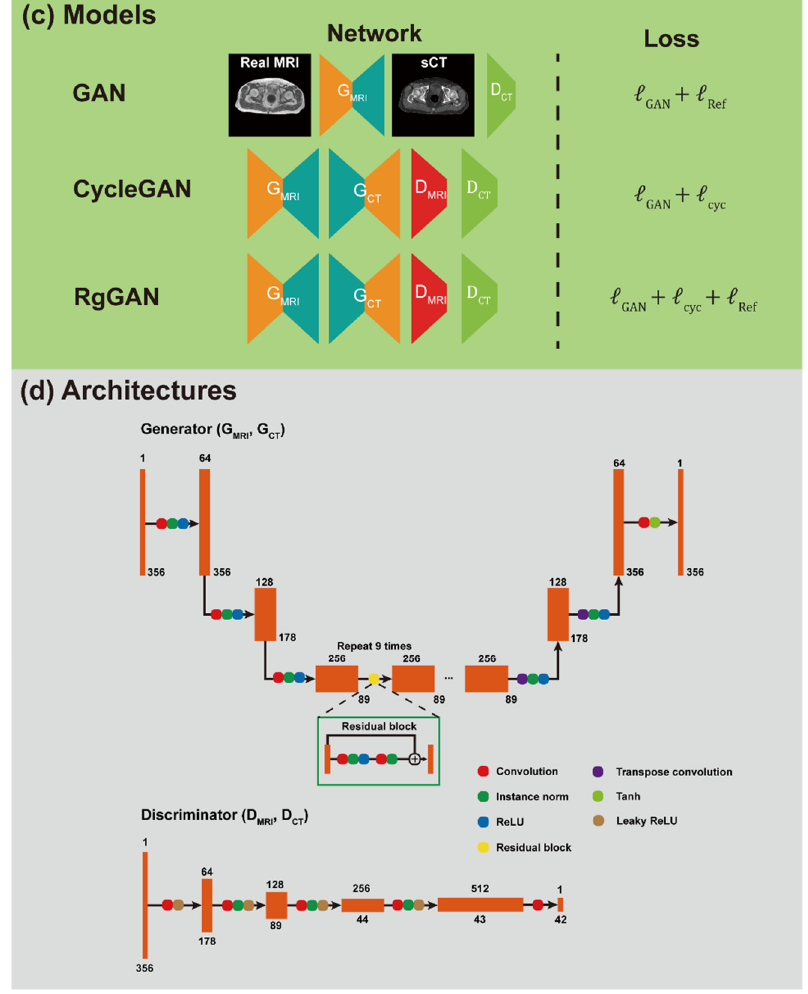
Figure 1. Schematic of the deep learning-based synthetic computed tomography (sCT) generation. ( a ) During training 2-dimensional (2D) axial slices are extracted from the volumes and fed to the model, which is shown as the cycle-consistent generative adversarial network (GAN) model. ( b ) The well-trained generator of magnetic resonance imaging (G MRI ) is used to generate 2D sCT images from the test magnetic resonance imaging volume at test time. The sCT slices are reassembled to 3-dimensional volume. ( c ) The GAN model only had the G MRI and discriminator (D CT ) networks and was trained with GAN and reference loss ( l GAN + l Ref ). The cycle-consistent GAN (CycGAN) model has four networks (G MRI , G CT , D MRI , and D CT ) and was trained with GAN and cycle loss (l GAN + l cyc ). The reference-guided CycGAN model (RgGAN), used the same networks as the CycGAN model and was trained with GAN, cycle, and reference loss (l GAN + l cyc + l Ref ). ( d ) Architectures of the generator and discriminator used in this study. The number at the top and bottom of the feature maps indicates the number of channels and spatial dimensions (width, height), respectively.